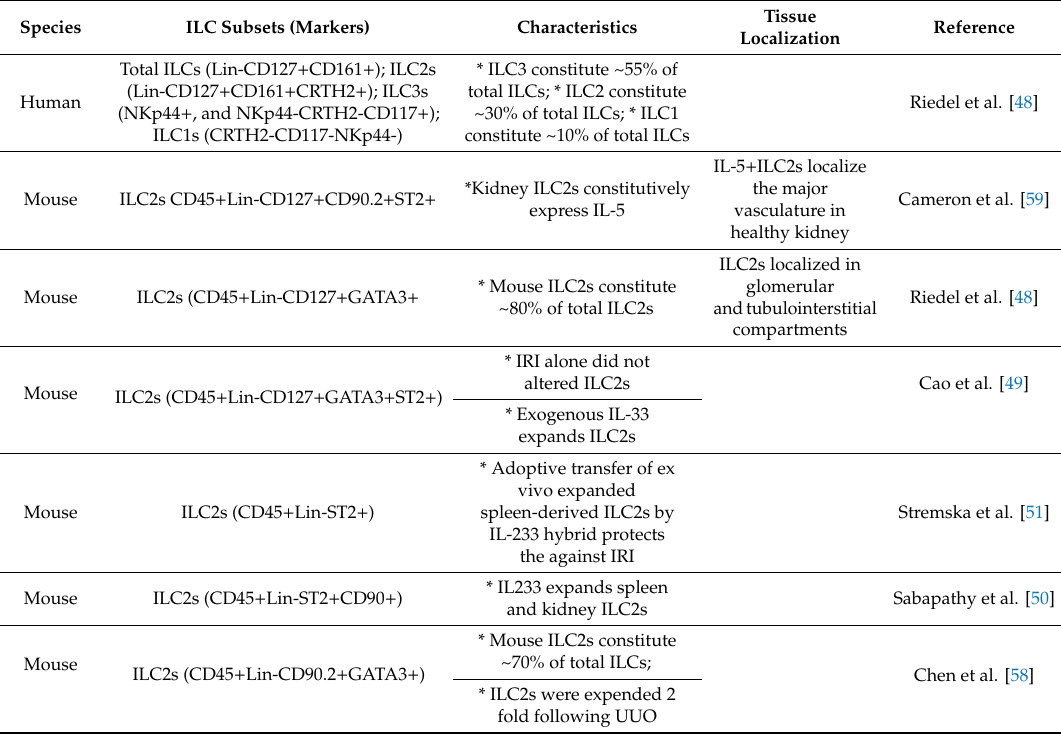
Table 1. Characterization of kidney group 2 innate lymphoid cells (ILC2s).